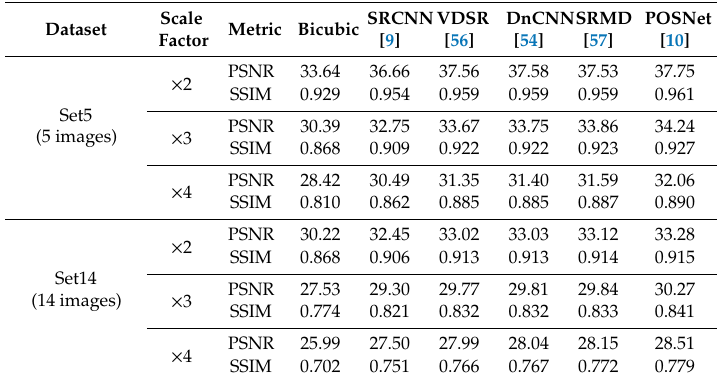
Table 3. Comparison of the quantitative super-resolution quality of the Set5 and Set14 databases in terms of average PSNR (dB) and SSIM.